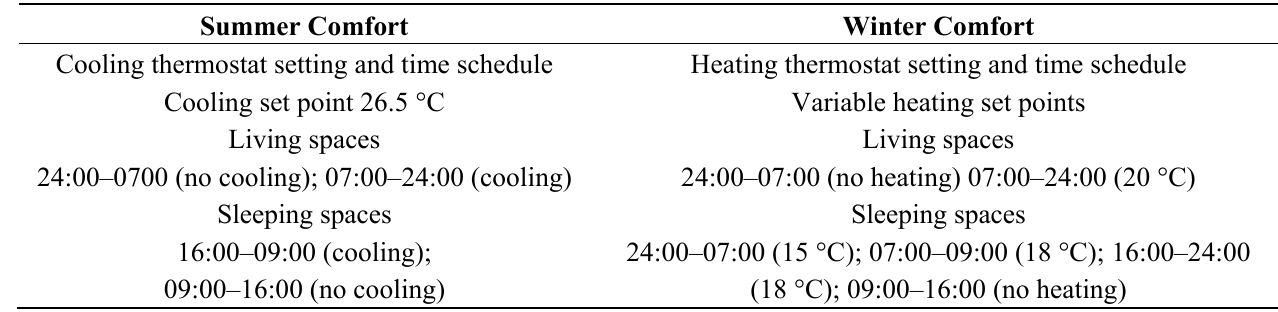
Table 1. Summer and winter cooling and heating schedule (as per